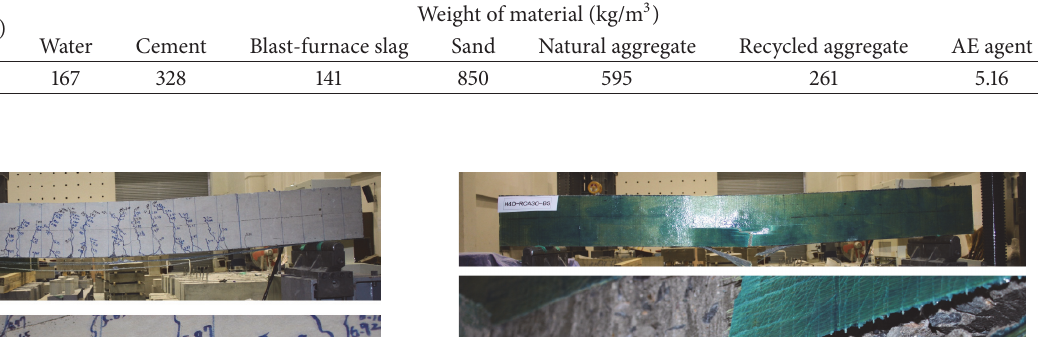
Table 5: Mix proportion of concrete specimen.